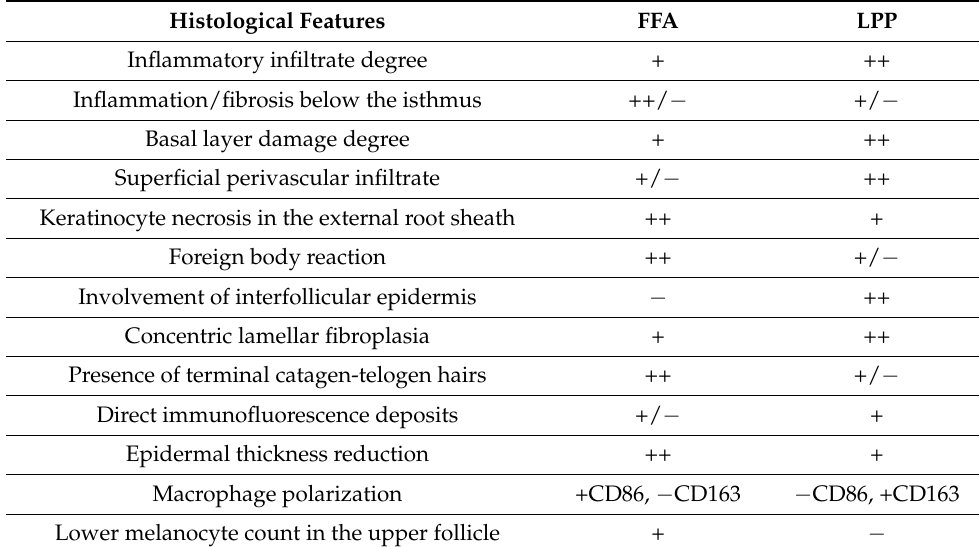
FFA: Frontal fibrosing alopecia. LPP: lichen planopilaris. ( − ) Absence, (+) Presence. (++) instead of (+) indicate a higher degree or intensity compared to the other (FFA vs LPP). A lower melanocyte count has been demonstrated in the upper follicle in FFA patients